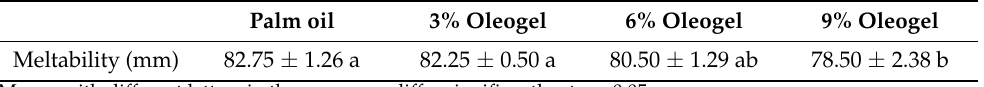
Table 4. Effect of palm oil replacement with oleogels on the meltability of imitation cheeses.